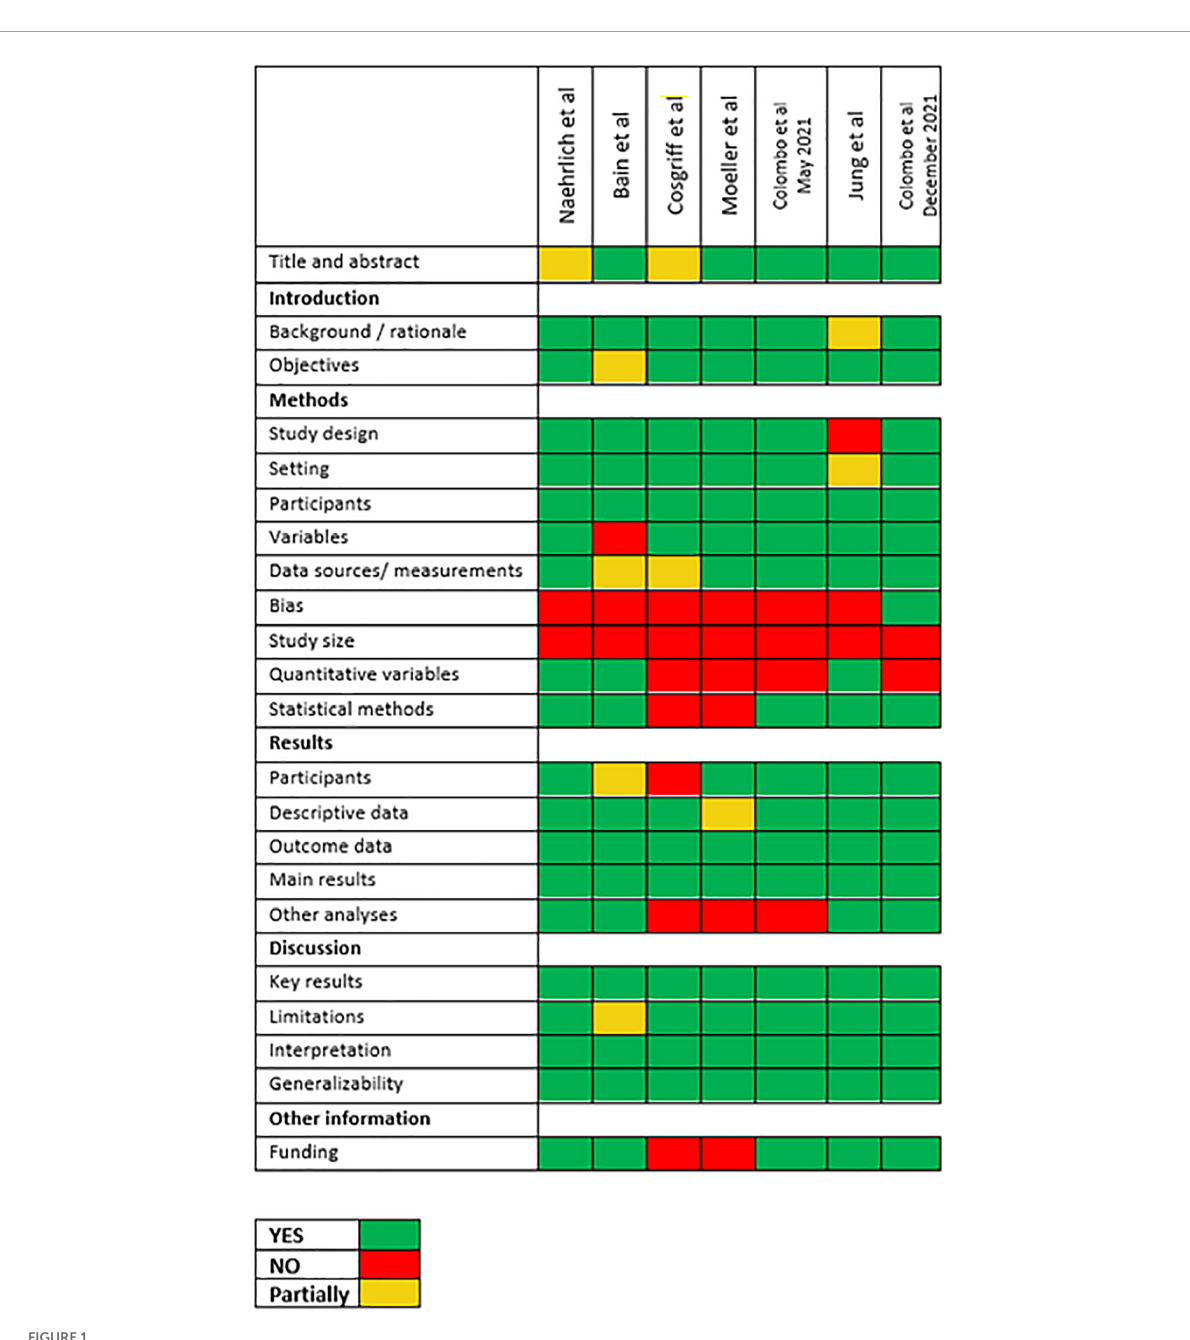
inclusion criteria. Six observational studies were included. Two reports were included after additional review prior to final drafting. Literature selection process is shown in Figure 2 ,